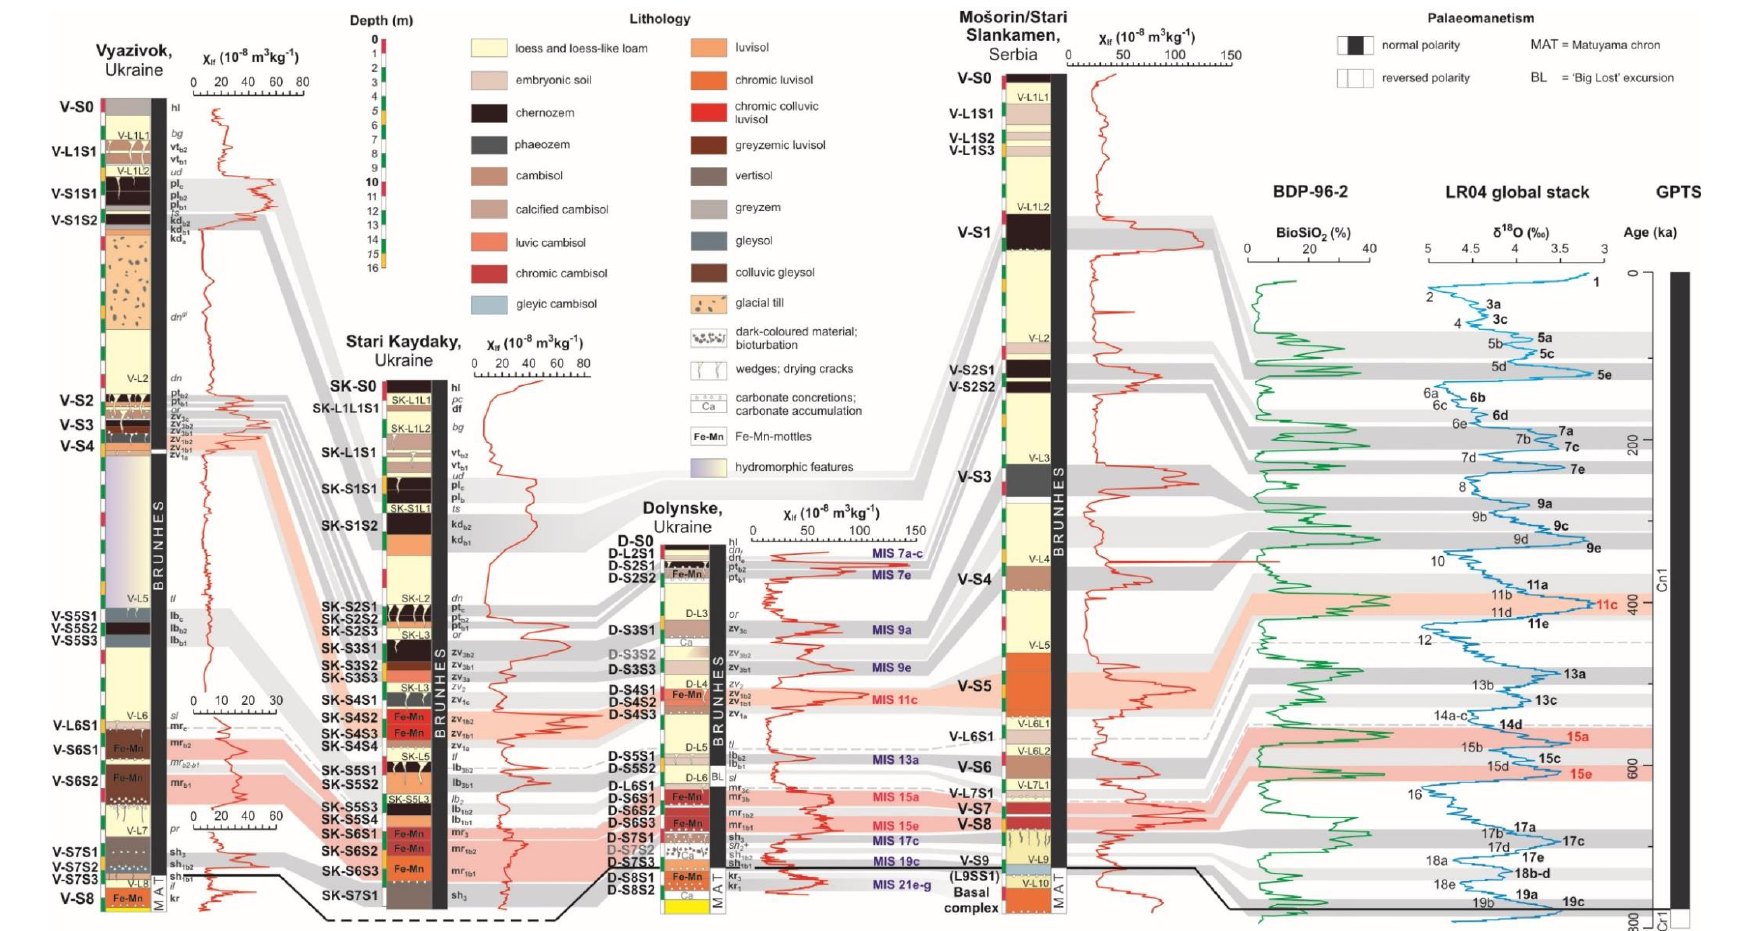
Figure 11. Correlation chart of the sequences studied at Vyazivok [150], Stari Kaydaky [235] and Dolynske (this study), Serbian reference sequence of Mošorin/Stari Slankamen, adapted with permission from Marković et al. [15], Elsevier, 2015, palaeoclimatic record of biogenic silica (%) from Lake Baikal, adapted with permission from Williams et al. [297], The American Association for the Advancement of Science, 1997, marine oxygen isotope stack LR04 [242] and Geomagnetic Polarity Time Scale. Magnetic susceptibility curve of the upper 17 m of the Stari Kaydaky section adapted with permission from Buggle et al. [11], Elsevier, 2015. Correlation of the V-S5 soil unit of Stari Slankamen with MIS 11 has been suggested by Sümegi et al. [28]. Correlation of V-S6 to V-S9 units with MIS 13 – 19 is proposed by this study.